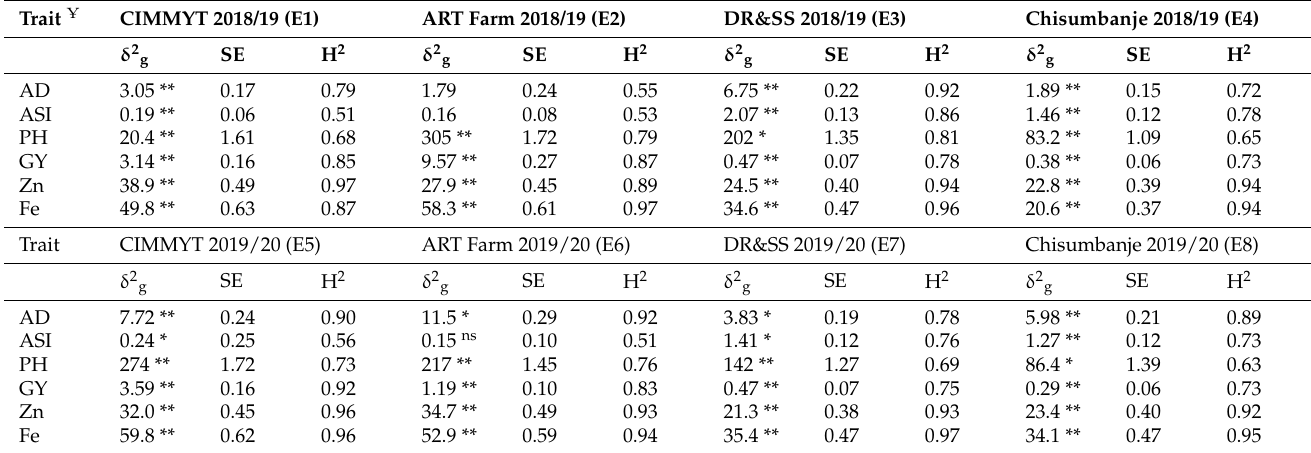
Table 3. Genotypic variance ( δ 2 g ), standard error (SE) and broad-sense heritability (H 2 ) for agronomic and micronutrient traits at eight experimental